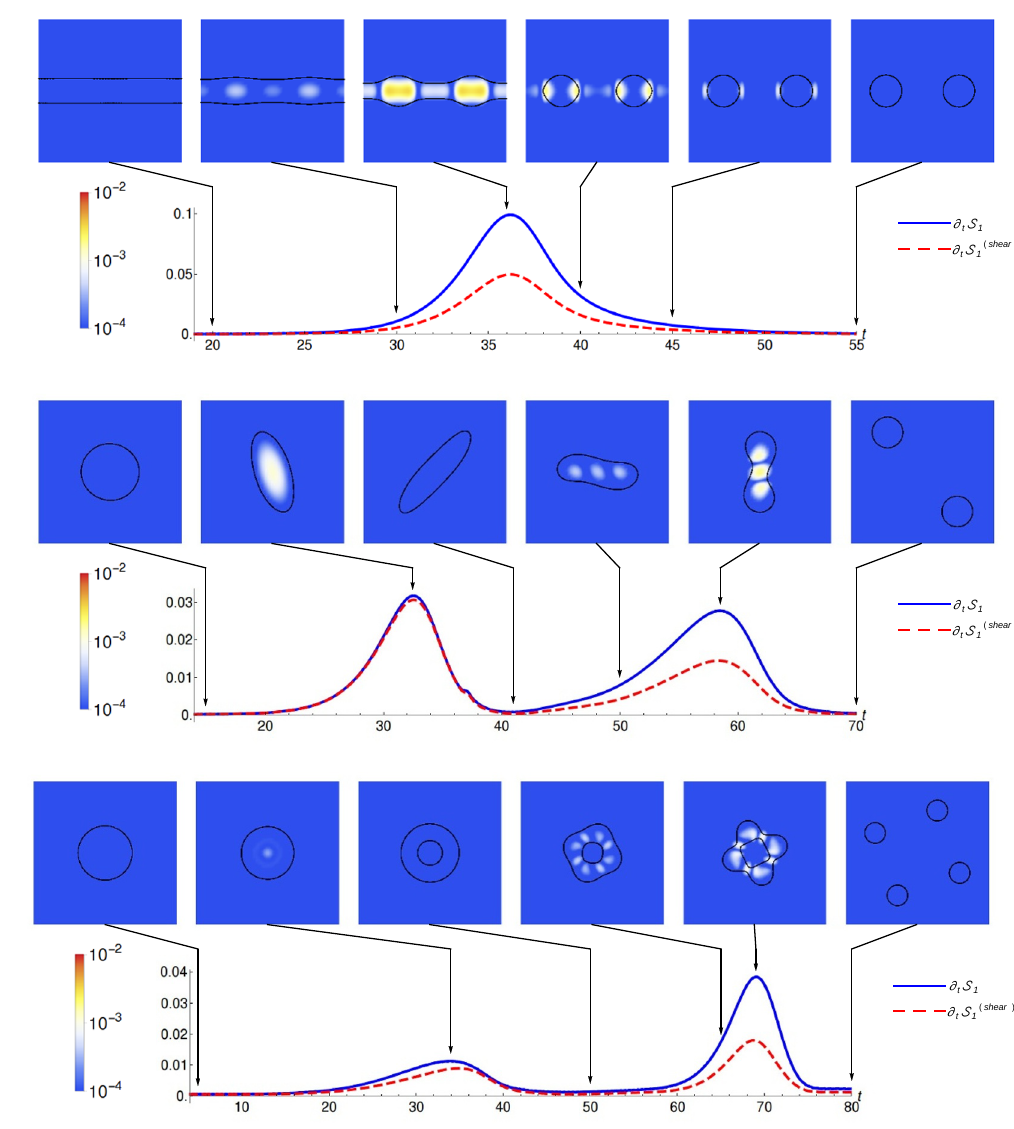
Figure 6 . Entropy production, as a function of time and space, during the decay of: unstable black string (top); ultraspinning MP black hole through intermediate black bar (middle); ultraspinning MP black hole through intermediate black ring (bottom). The blue curves give the production rate of the NLO entropy, @ t S 1 (integrated in space); the dashed red curves are the production rate through dissipation of shear (and not of expansion), @ t S (shear) . The density plots show the time 1 derivative of the entropy density (colors in log scale). The thin black contours serve to guide the eye to where the black hole blobs are, and correspond to m ( x; y ) = 0 : 001 M . We can see that the pattern of entropy production in the black string decay is reproduced in the second peak of the decays of the MP black hole. The (cid:12)rst peak is mostly due to shearing when the intermediate black bar or black ring forms.